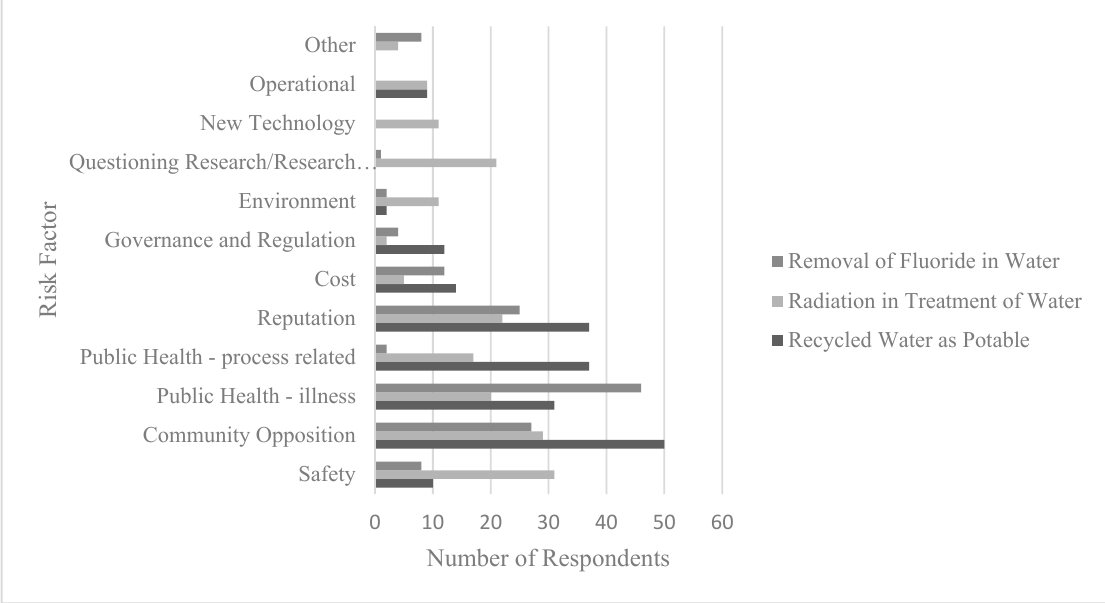
Figure 1. Water professionals’ risk perceptions by project.